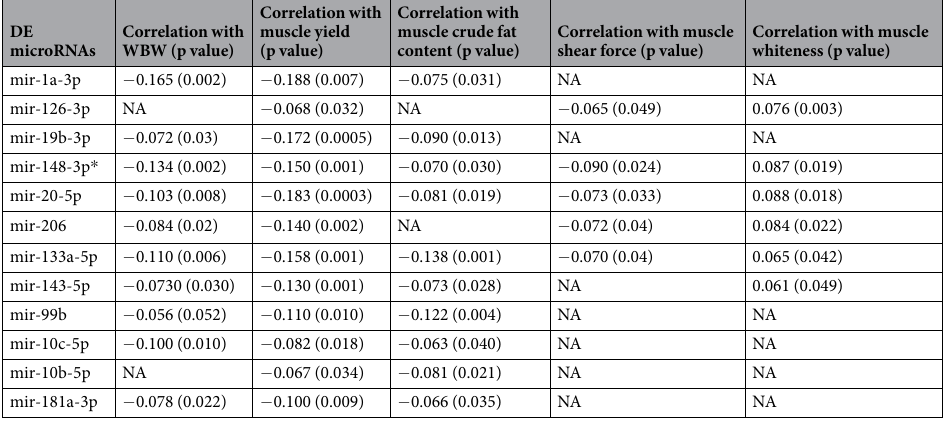
Table 3. Correlation between microRNA expression level and phenotypic variation for different muscle quality traits. Correlation was performed based on real time PCR quantification of microRNAs in 90 random individual fish and their phenotypic measurements for different traits. Negative value ( − ) indicates negative